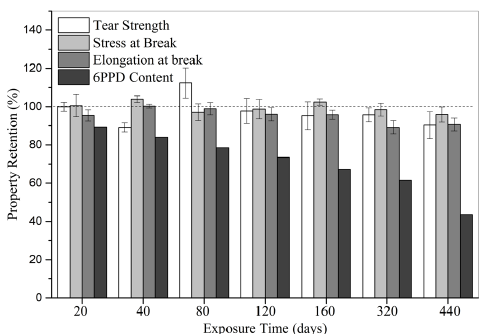
Figure 11. Retention of 6PPD in oven thermo-oxidative aging comprising 1.5 phr of TMQ in combination with different 6PPD Figure 12. Retention of property in environmental aging of the composition comprising 2.5 phr of 6PPD and 1.0 phr of